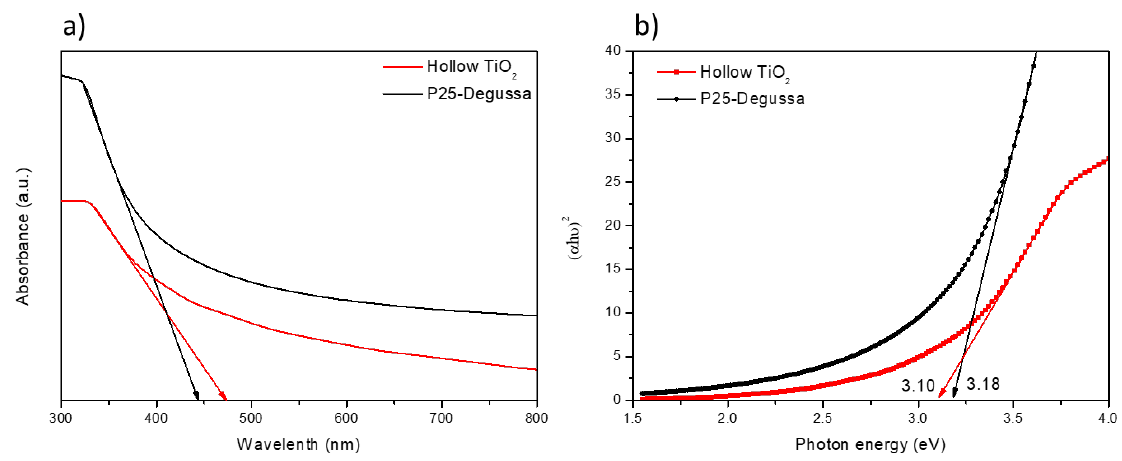
Figure 4. ( a ) UV-vis absorbance spectra. ( b ) Band gap energy of the P25 and TiO 2 hollow nanospheres.